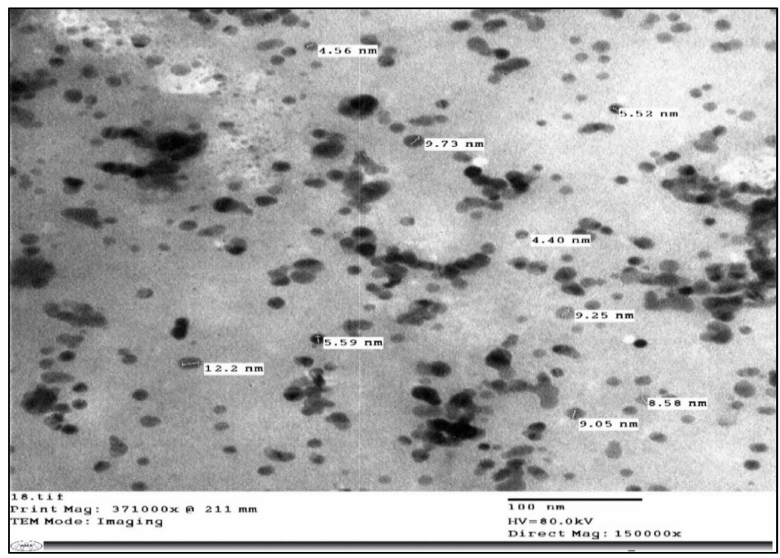
Figure 2. Electron micrographs of silver nanoparticles synthesized by the crude aqueous extract from Moringa and NaBH 4